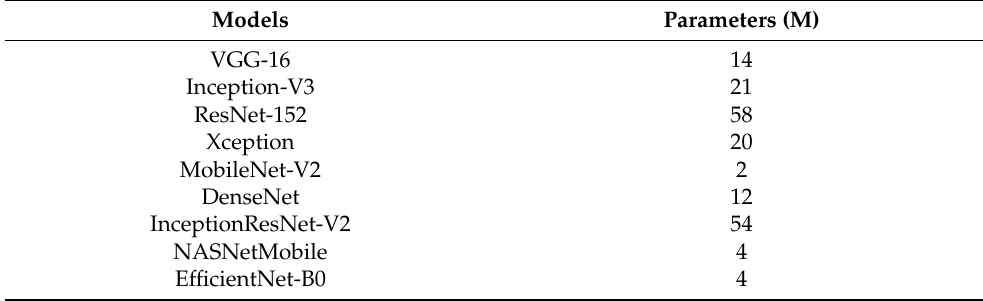
Figure 8. Feature map representations of input images extracted from the intermediate layers of the proposed ensemble network. Table 9. Parameters of the fine-tuned